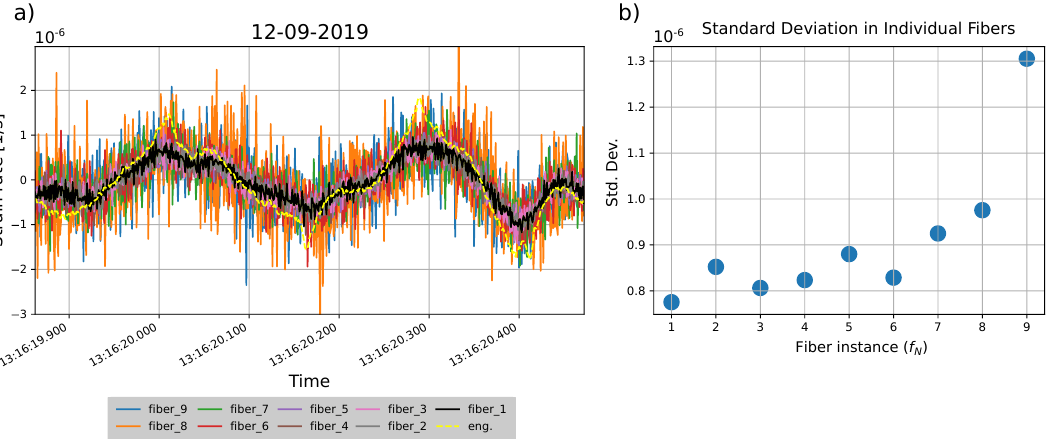
Figure 5. Fiber instance comparisons. ( a ) Raw signal from a volcanic tremor from Mt. Etna, recorded at equivalent channels between the standard fiber instances and the engineered fiber. For raw data, each fiber is labeled with its specific color below. The equivalent channels are 336 and 261 for standard fiber one and engineered fiber, respectively. Other equivalences between the other fibers can be found in the Supplementary Materials. ( b ) Standard deviation values (blue dots) at each standard fiber instance for a defined time window of the volcanic tremor. All the length of the fiber was used instead of the shared section with the engineered